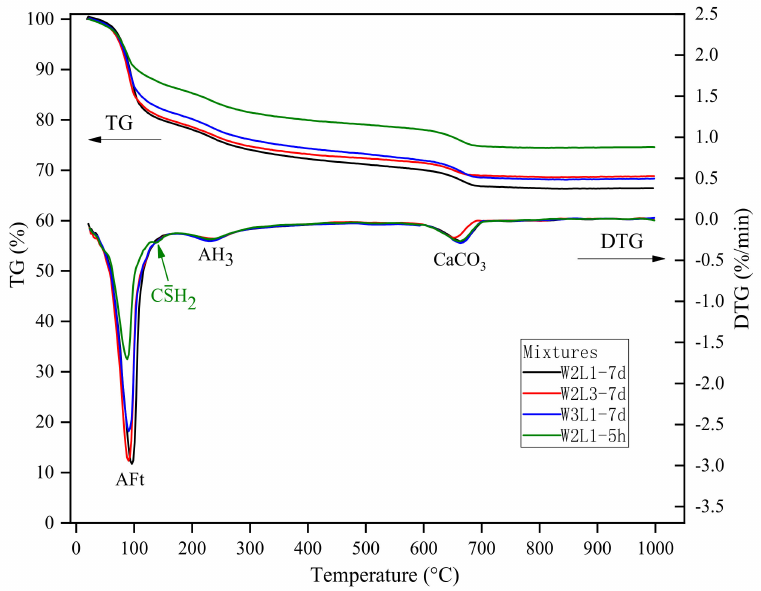
Figure 7. TG and DTG curves of the high water grouting material with different mixtures and curing ages.